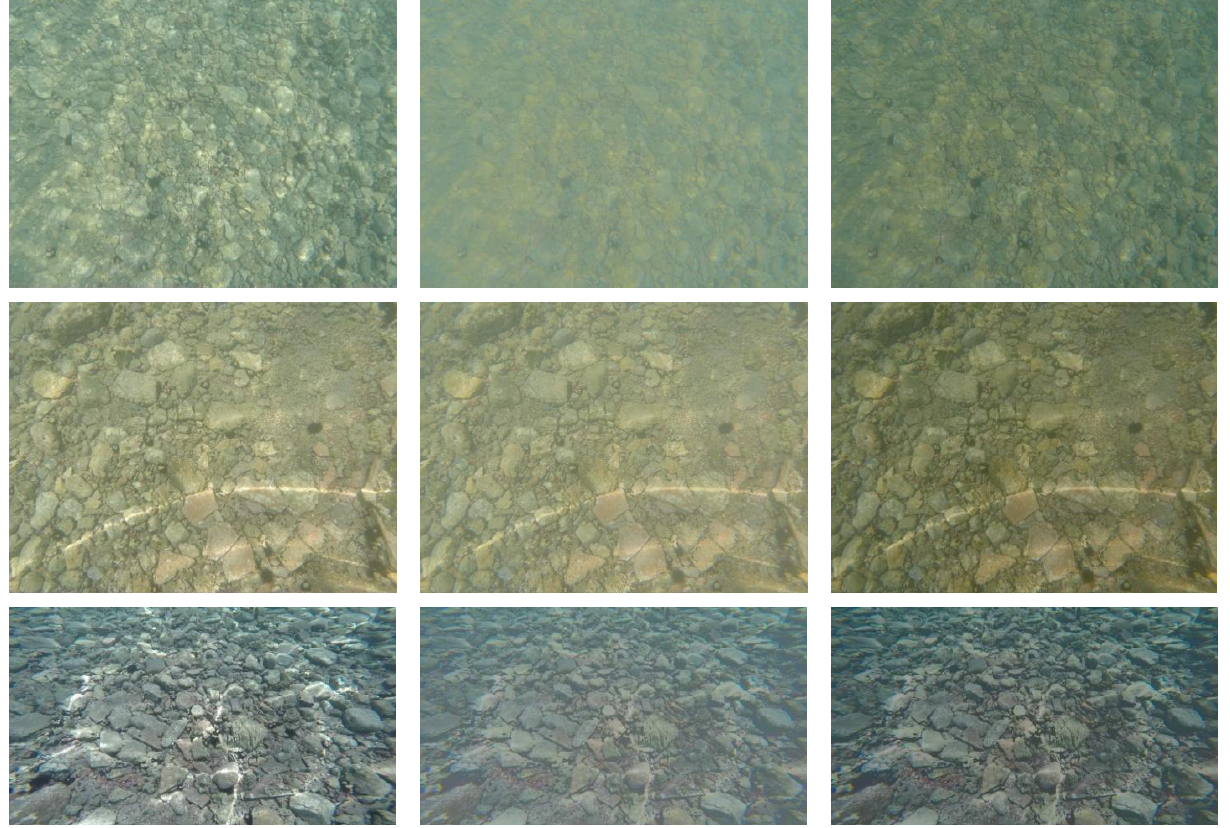
Figure 3. The five different datasets used: on the first row, an image from dataset 1, of the following rows, images from the respective datasets 2, 3, 4 and 5. Left column: The original RGB images, which contain caustics of varying characteristics. Middle column: The images which were processed using the network and then histogram matched to the colour transferred image. Right column: The caustic-free images which were processed using the network and then histogram matched to the original